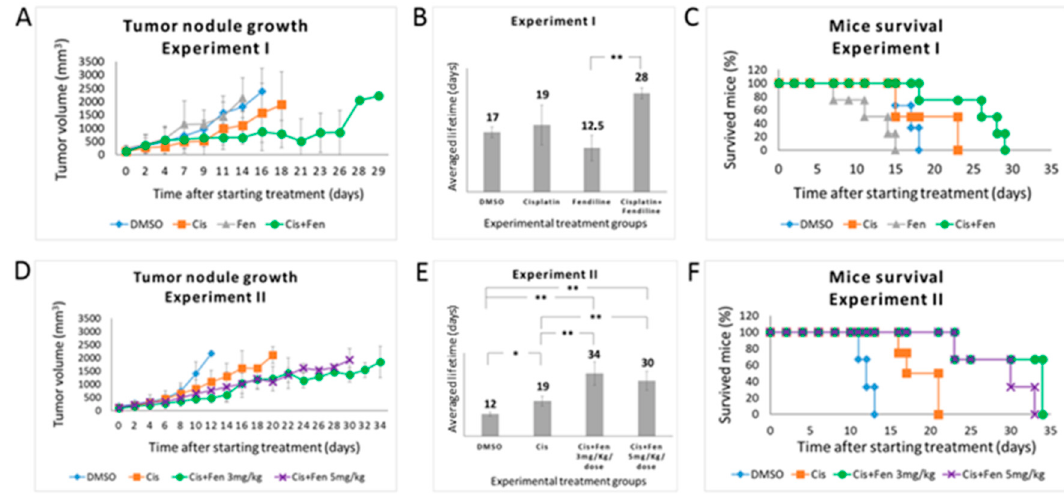
Figure 3. Fendiline hydrochloride in co-administration with cisplatin reduces the growth of tumor nodules in vivo and increases mice survival. ( A ) Tumor nodules growth rate in NOD-SCID mice treated with different drug combinations. In the first experiment, mice were randomized to receive the following treatments: vehicle (1% DMSO) once a day for 5 days/week; fendiline (3 mg/kg/dose), once a day for 5 days/week; cisplatin (5 mg/kg/dose), weekly; fendiline (3 mg/kg/dose), once a day for 5 days/week in co-administration with cisplatin, weekly. Mice were sacrificed when the tumor size reached 2.2 cm 2 . ( B , C ) Statistical analysis of Kaplan–Meier plots of the first in vivo experiment. Log Rank test showed a statistically significant difference ( p < 0.05) between the following groups: (i) DMSO vs fendiline; (ii) fendiline co-administered with cisplatin vs DMSO; (iii) fendiline co-administered with cisplatin vs cisplatin; iv) fendiline co-administered with cisplatin vs fendiline. ( D ) Tumor nodules growth rate in NOD-SCID mice treated with different drug combinations. In the second experiment, mice were randomized to receive the following treatments: vehicle (1% DMSO), once a day for 7 days/week; cisplatin (5 mg/kg/dose), weekly; fendiline using either 3 mg/kg/dose or 5 mg/kg/dose, once a day for 7 days/week in co-administration with cisplatin, weekly. ( E , F ) Log Rank test of Kaplan–Meier plots showed a statistically significant difference ( p < 0.05) between the following groups: (i) DMSO vs cisplatin; (ii) fendiline 3 mg/kg/dose co-administrated with cisplatin vs DMSO; (iii) fendiline 5 mg/kg/dose co-administrated with cisplatin vs DMSO; (iv) fendiline 3 mg/kg/dose co-administrated with cisplatin vs cisplatin; (v) fendiline 5 mg/kg/dose co-administrated with cisplatin vs cisplatin. Values are reported as the mean ± SD. * indicates p ≤ 0.05, ** indicate p ≤ 0.01; two-tailed Student’s t test was applied.